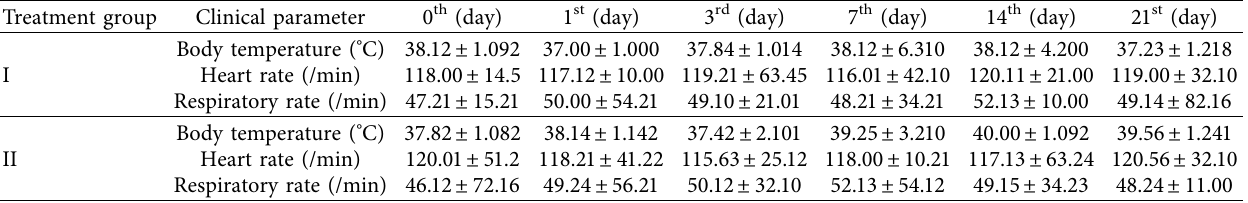
Table 2: Mean ± SE values of clinical/physiological parameters in dogs with malignant mammary tumor prior treatment in both the groups at periodical intervals.